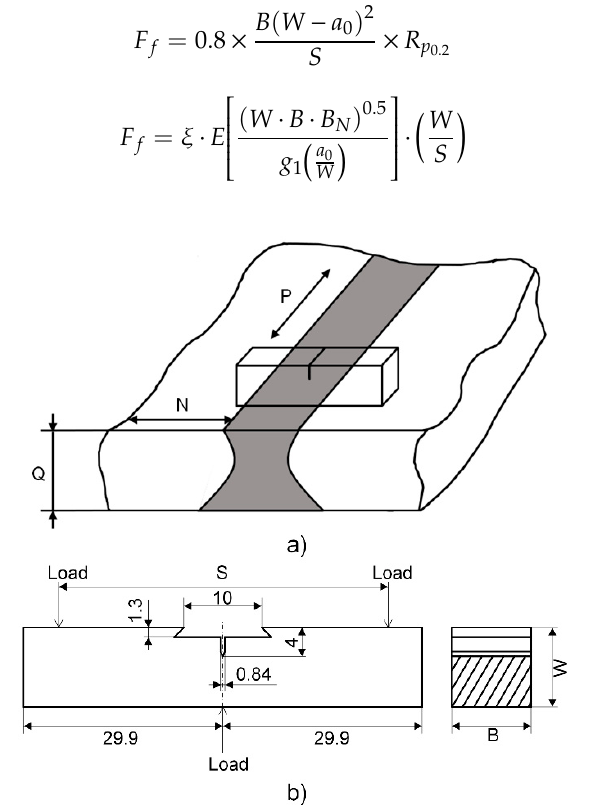
Figure 4. Three-point bending ( a ) specimen sampling orientation; and, ( b ) dimension (mm).